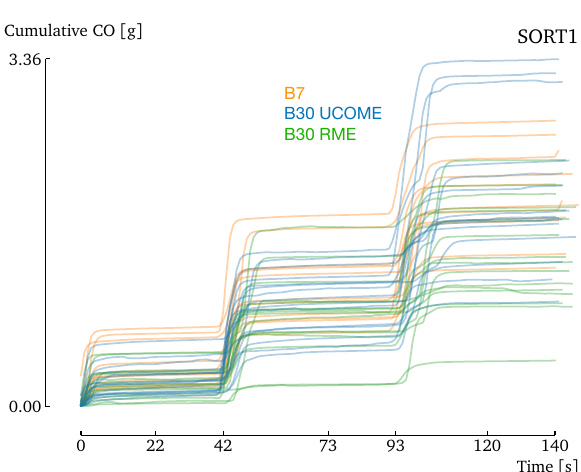
Figure 15. A large spread in cumulative CO emissions is measured among the different SORT repetitions without regard for the used fuel.